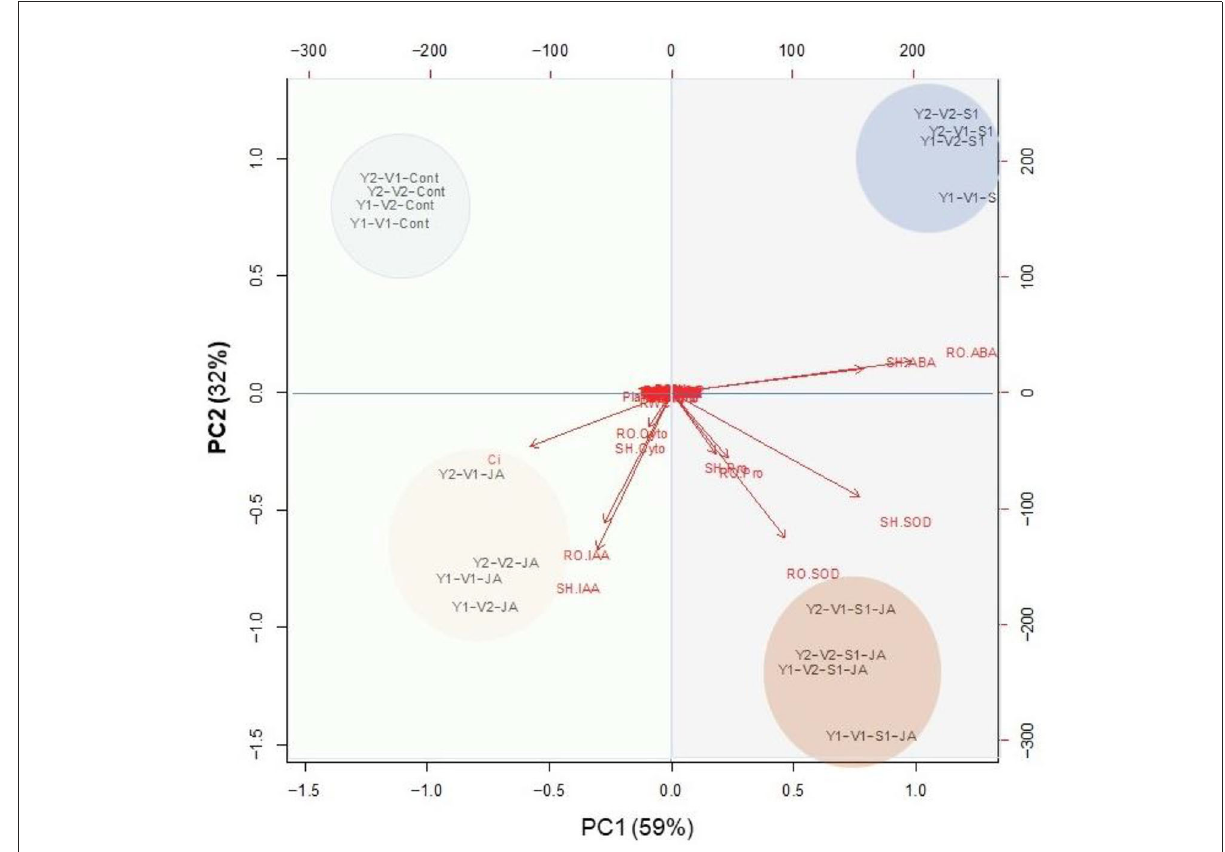
FIGURE8 A principal component analysis (PCA) determines the degree of association within the treatments and variables of two wheat cultivars Mai9 (ZM9, salt-sensitive) and Yang Mai25 (YM25, salt-tolerant) primed with jasmonic acid (JA) and grown under salinity